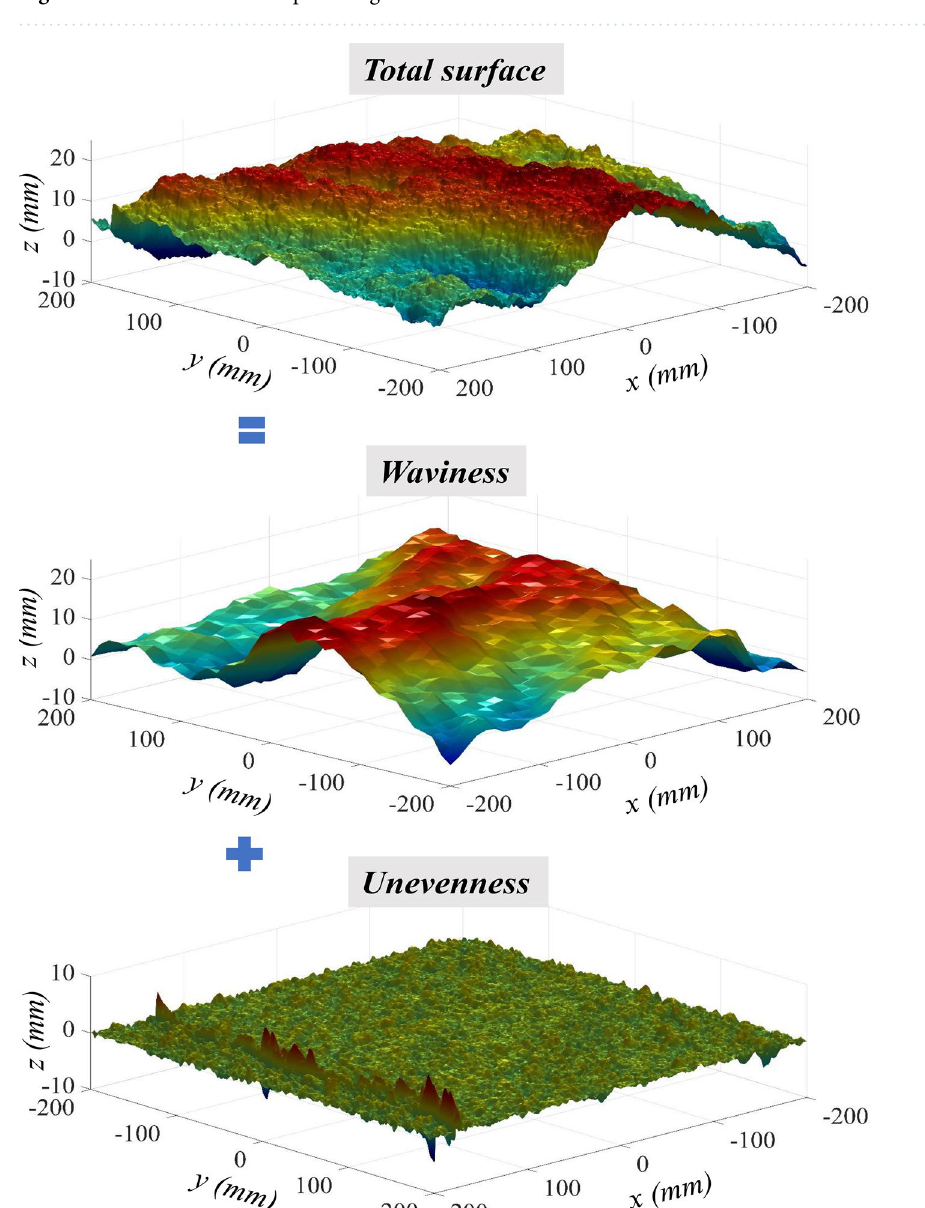
Figure 5. Separation of a rock joint surface into waviness and